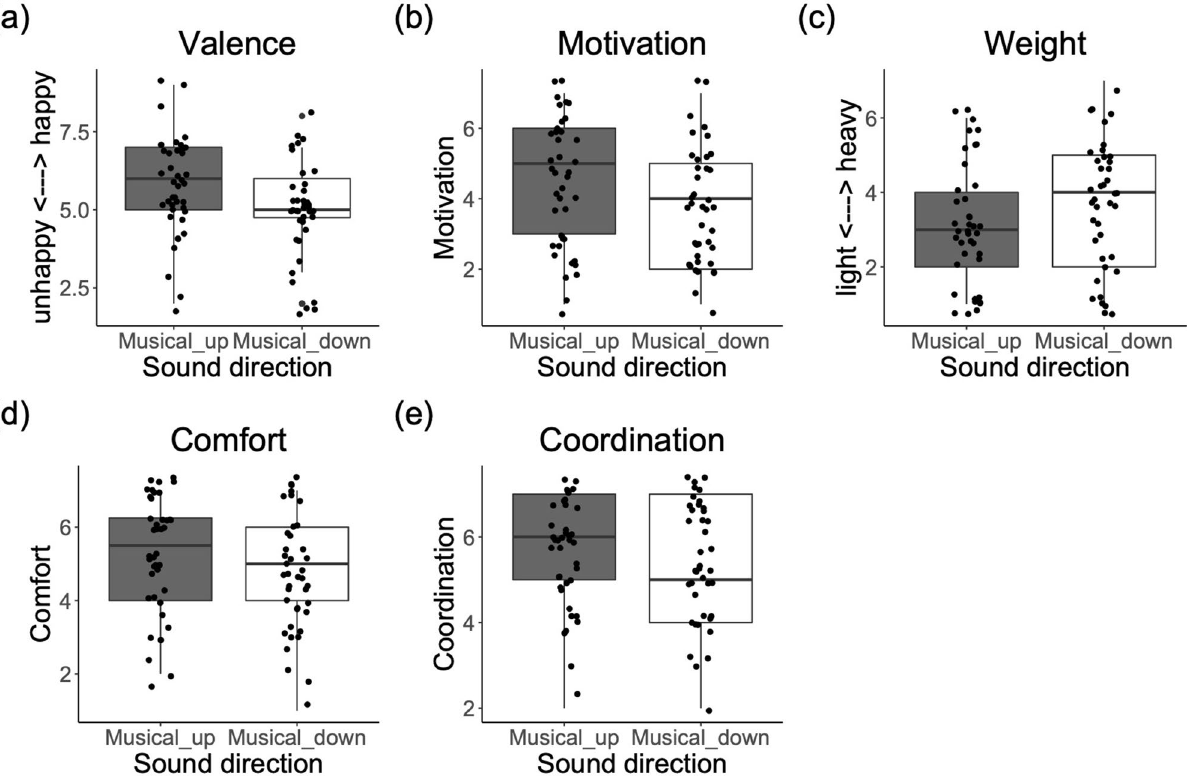
Figure 4. Boxplots with median (range) score for questionnaire items showing significant effects of Sound Direction in Experiment 3. ( a ) Reported emotional valence (happiness) and ( b ) motivation; and ( c ) feelings of body weight, ( d ) movement comfort and ( e ) coordination.